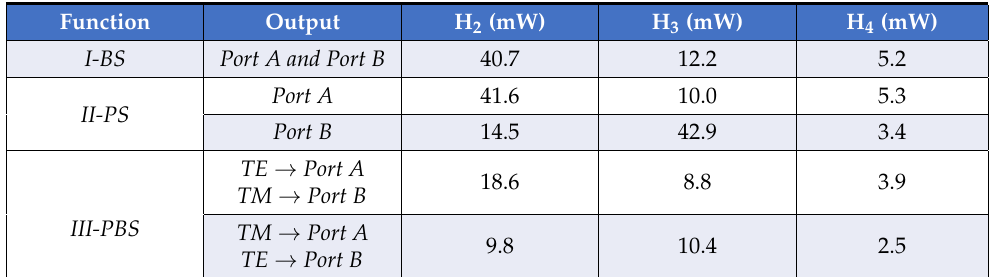
Table 3. Heat power configurations for the I-BS, II-PS, and III-PBS functions in the experiment.